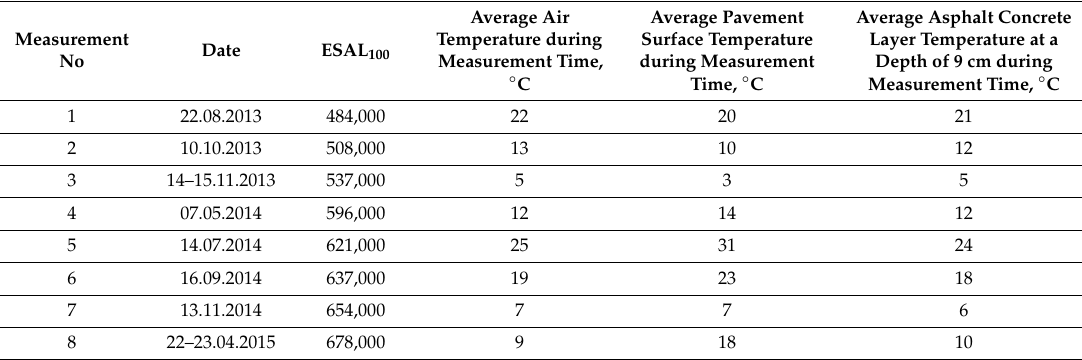
Table 2. Date of deflection measurements in sections.